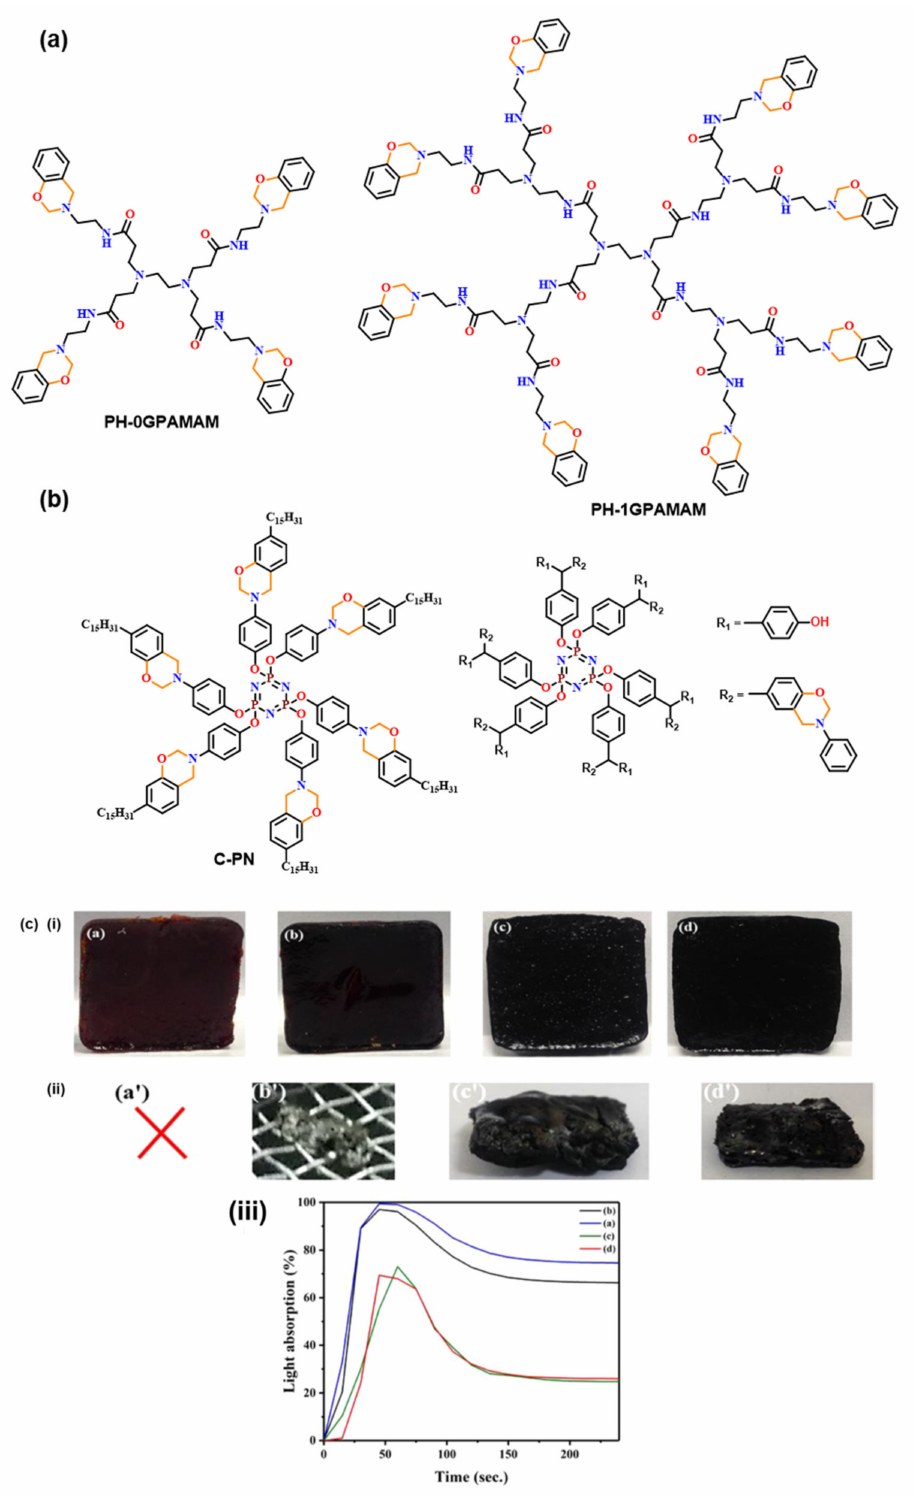
Figure 7. Higher order benzoxazine monomers with ( a ) 0th and 1st generation PAMAM den- dritic [143], ( b ) phosphazene core [18,148] and ( c ) flame resistive analysis: digital images of cured samples [l × w × h: (25.0 ± 0.1) × (25.5 ± 0.1) × 3.0 mm] of poly (C-trisapm) and poly (C-PN) blends in different ratio (a) 100:0, (b) 90:10, (c) 20:80 and (d) 0:100 (i) before and (ii) after smoke density test; (iii) plot of light absorption by sensor with time during burning of the sample [18]. Copyright 2017. Reproduced with permission from American Chemical Society, Washington, DC,